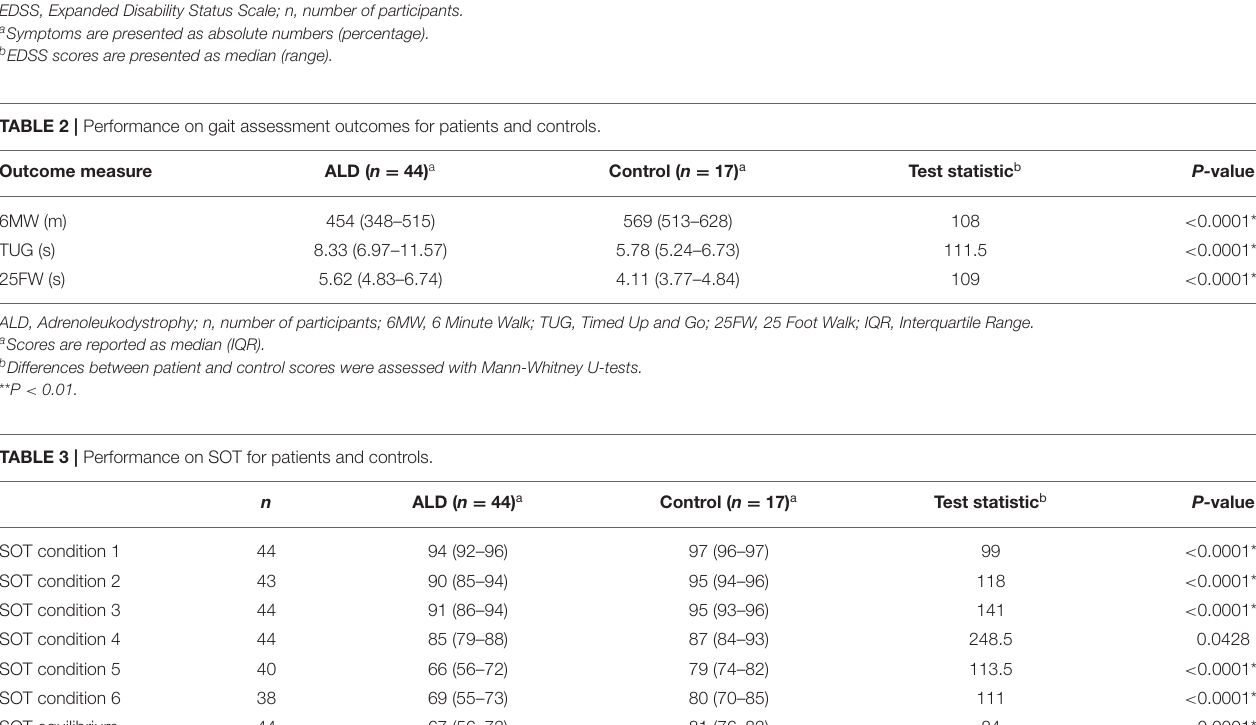
Neurological symptoms a